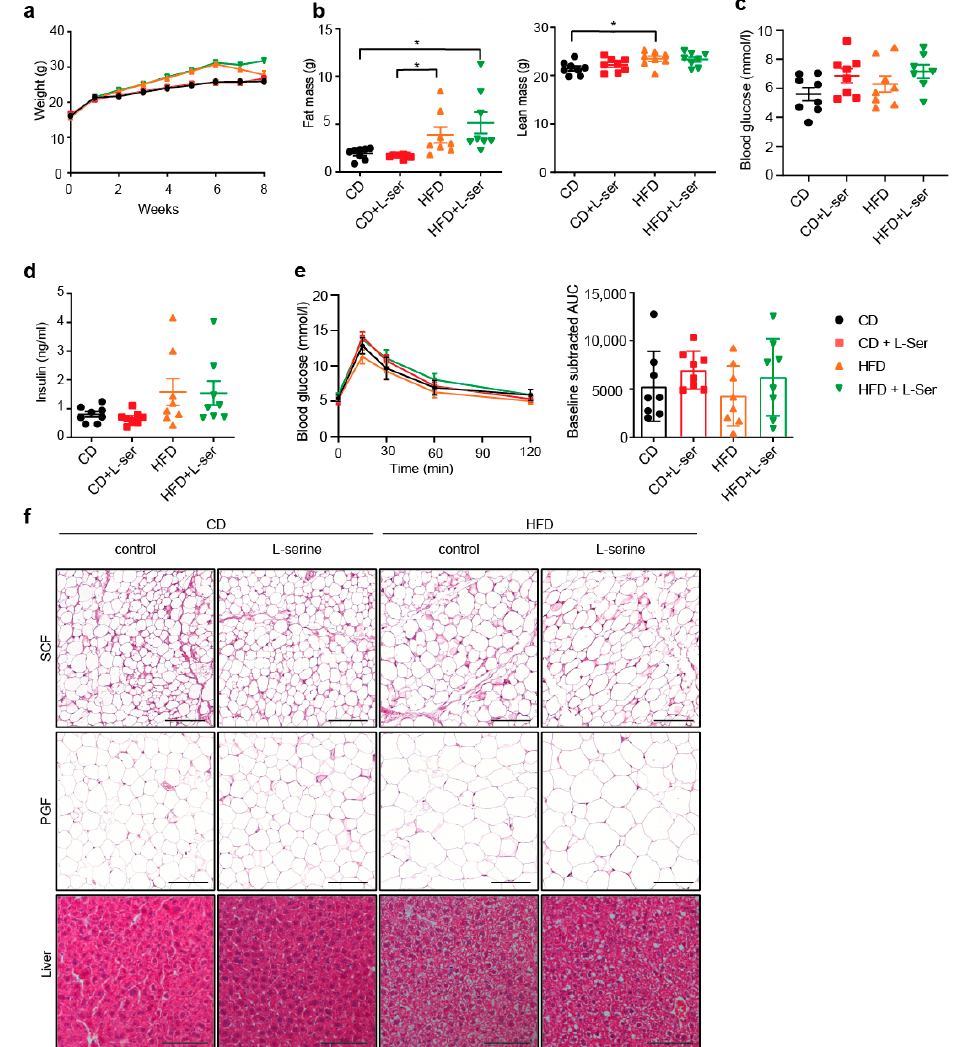
Figure 1. L-serine supplementation has no major effects on metabolism in ad libitum -fed mice. ( a ) Body weight of chow diet (CD) and high-fat diet (HFD) fed mice supplemented with or without L-serine for 8 weeks, starting at 4 weeks of age ( n = 8). ( b ) Body composition (fat and lean mass) of CD-fed and HFD-fed mice with and without L-serine supplementation assessed after 8 weeks ( n = 8). ( c ) Randomly fed blood glucose levels of CD-fed and HFD-fed mice with and without L-serine supplementation after 3 weeks ( n = 8). ( d ) Randomly fed insulin levels of CD-fed and HFD-fed mice with and without L-serine supplementation after 3 weeks. ( e ) Glucose Tolerance Test (GTT) and baseline subtracted area under the curve (AUC) of CD -fed and HFD-fed mice with and without L-serine supplementation at week 6 ( n = 8). ( f ) Representative H&E stainings of perigonadal fat (PGF), SCF (subcutaneous fat) and liver of random CD-fed and HFD-fed mice with or without L-serine supplementation after 8 weeks. Scale bars represent 100 µ M. Data are shown as mean ± SEM, one or two-way ANOVA with Tukey’s post-test. * p < 0.05. 3.2. L-Serine Supplementation Blunts Body Weight Regain after Repeated Overnight Fasting Pyruvate tolerance tests (PTTs), in contrast to insulin and glucose tolerance tests (GTTs), require an overnight fast to deplete hepatic glycogen stores. This results in a ~10–